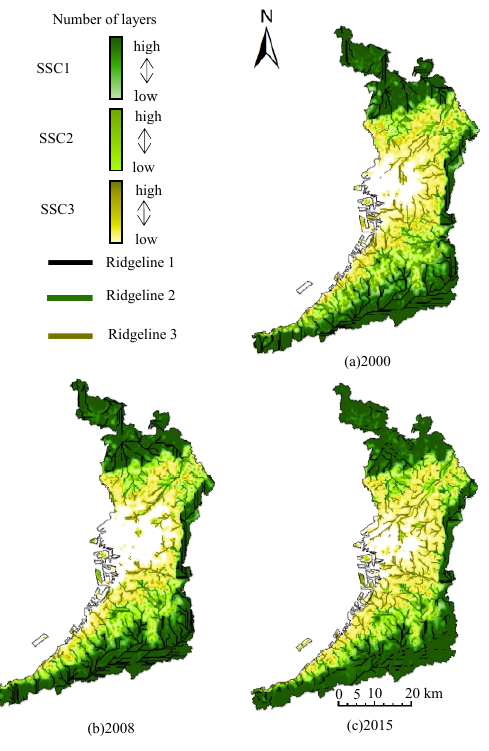
Figure 3. Results of the spatial